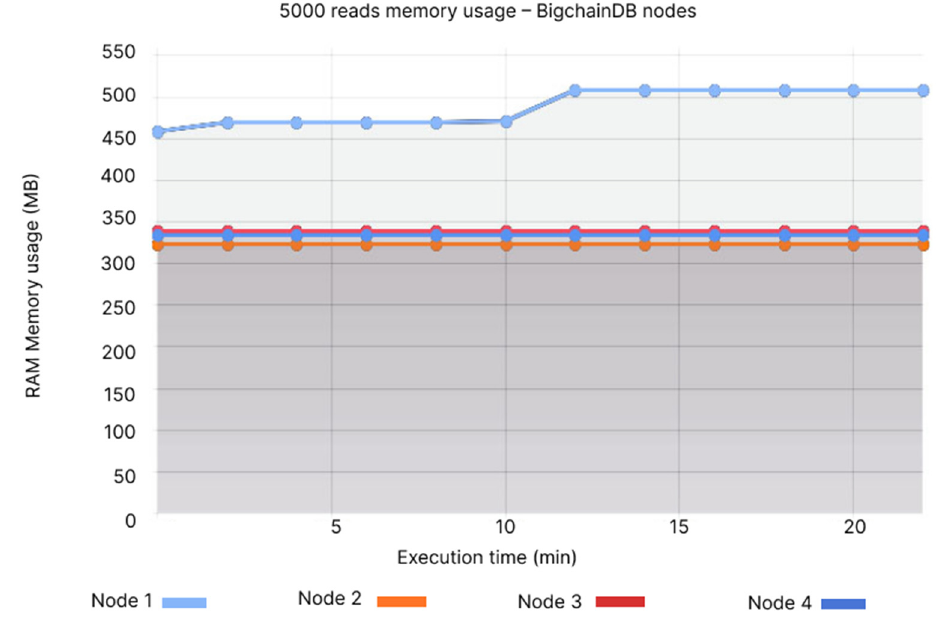
Figure 24. 5000 reads memory usage—BigchainDB nodes.